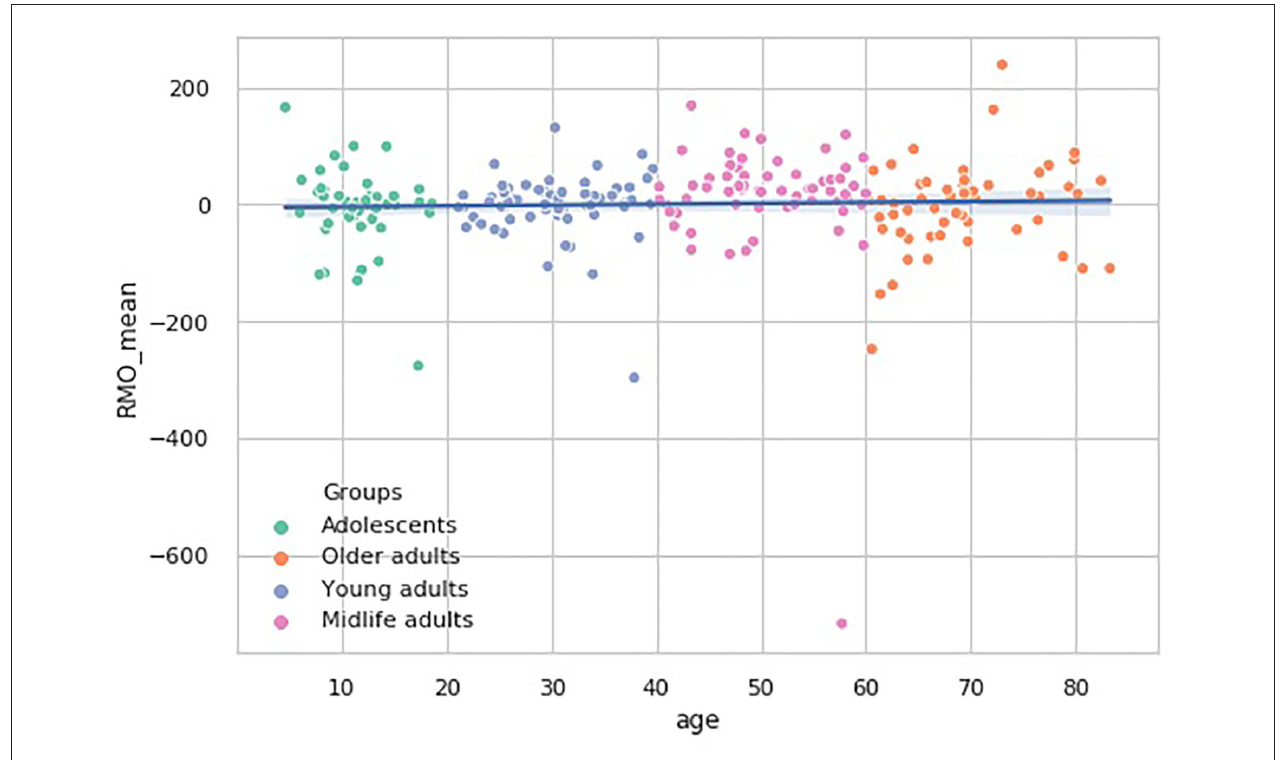
FIGURE 8 | Over-the-age distribution of time estimate values in RMO test.